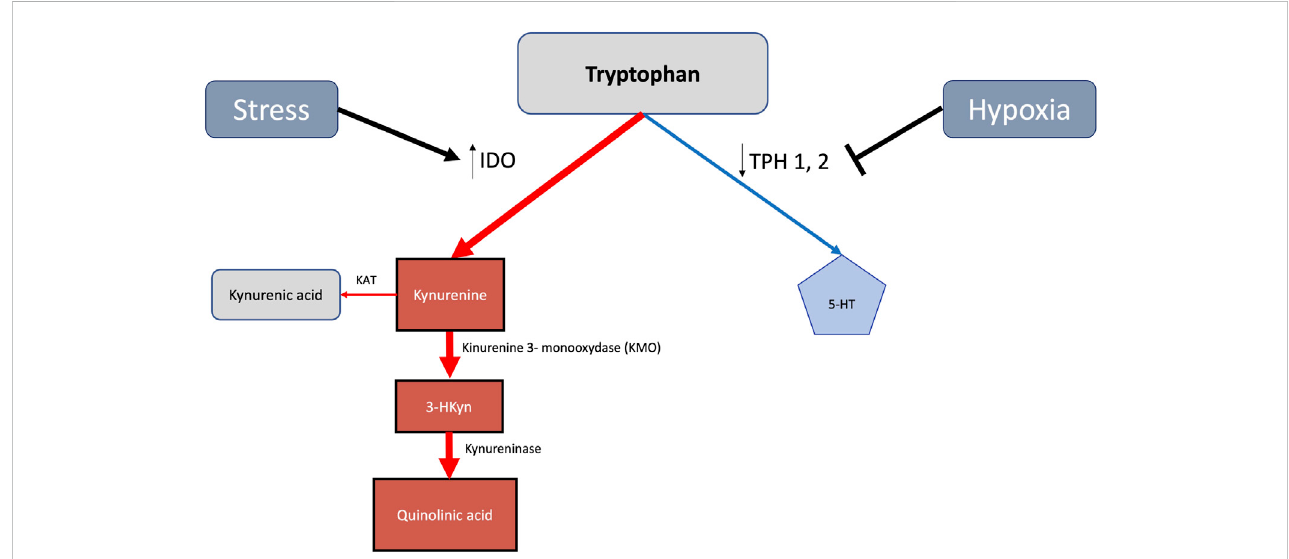
FIGURE 1 Stress and hypoxia mediated increase of the tryptophan derived metabolic kynurenine 128 pathway in detriment of 5-HT generation. Indoleamine 2,3- dioxygenase (IDO), being upregulated 129 by stress, enhances toxic kynurenine signaling. By reducing tryptophan hidroxylase (TPH) activities, 130 hypoxia concomitantly diminishes 5-HT